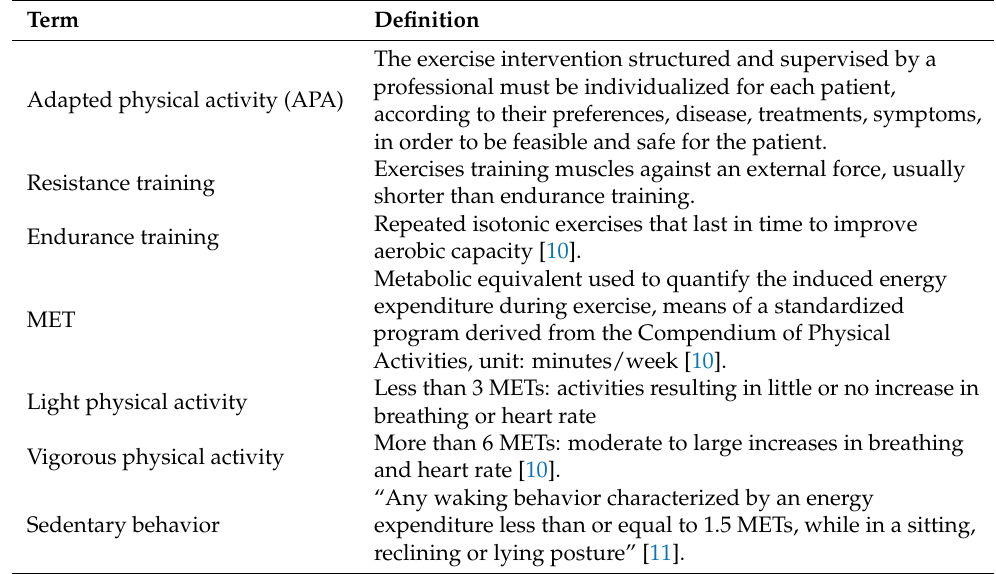
Table 1. Definitions of the terms used to characterize exercise in the clinical